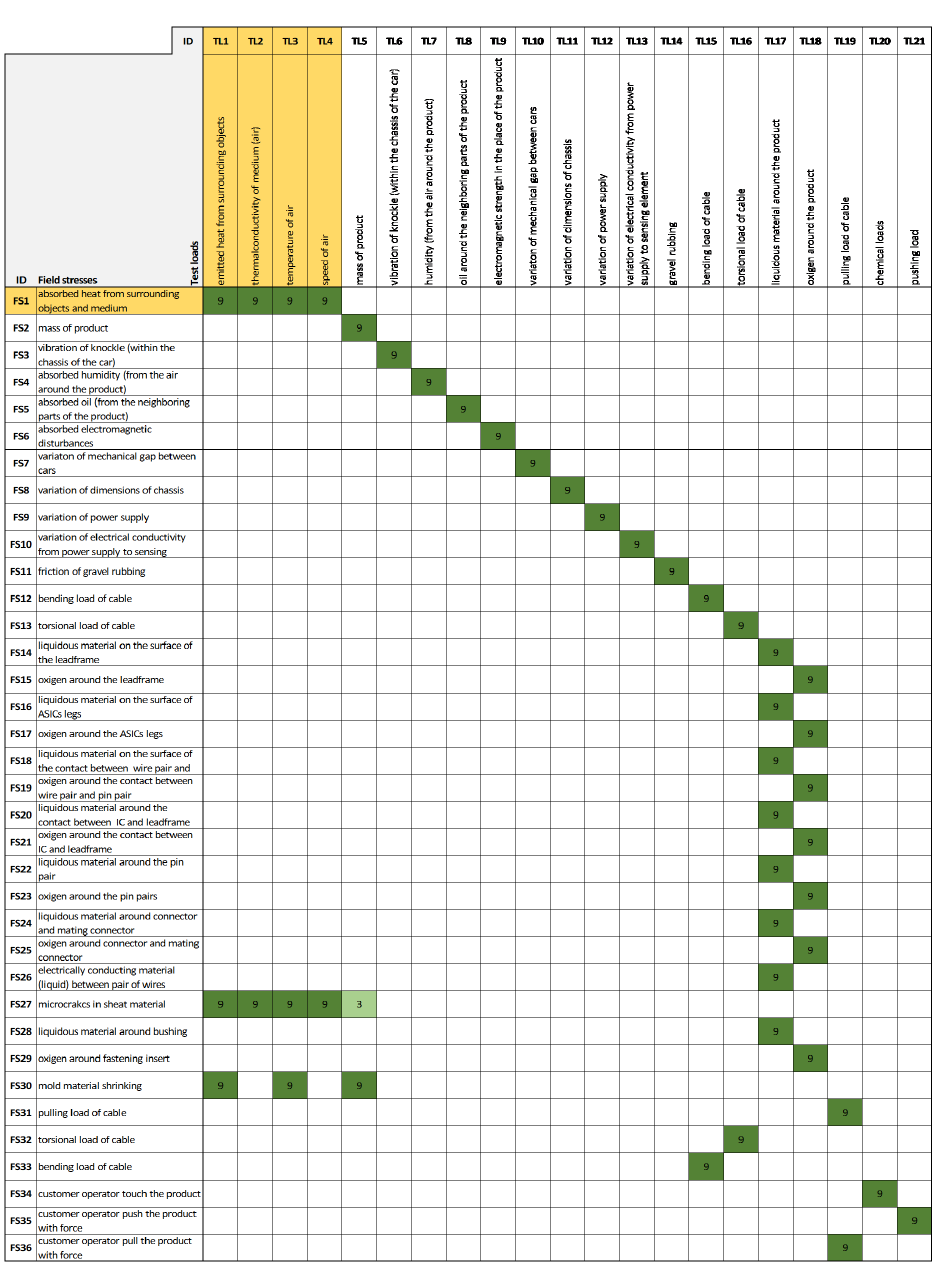
Figure 10. House of Test Loads: this is the fourth House of Noises: Field stresses vs. Test loads. The House of Test Loads connects the direct causes from the House of Field Stresses (output of the House of Field Stresses) to its direct causes. In the example, this is the last House of Noises, which—as the output—contains the ranked test